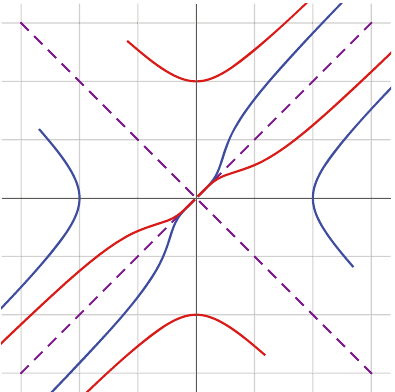
Figure 7: Spacelike ( blue ) and timelike ( red ) curves in (cid:2) 2 such that (cid:2) ( ) = ρ ρ ρ − 2